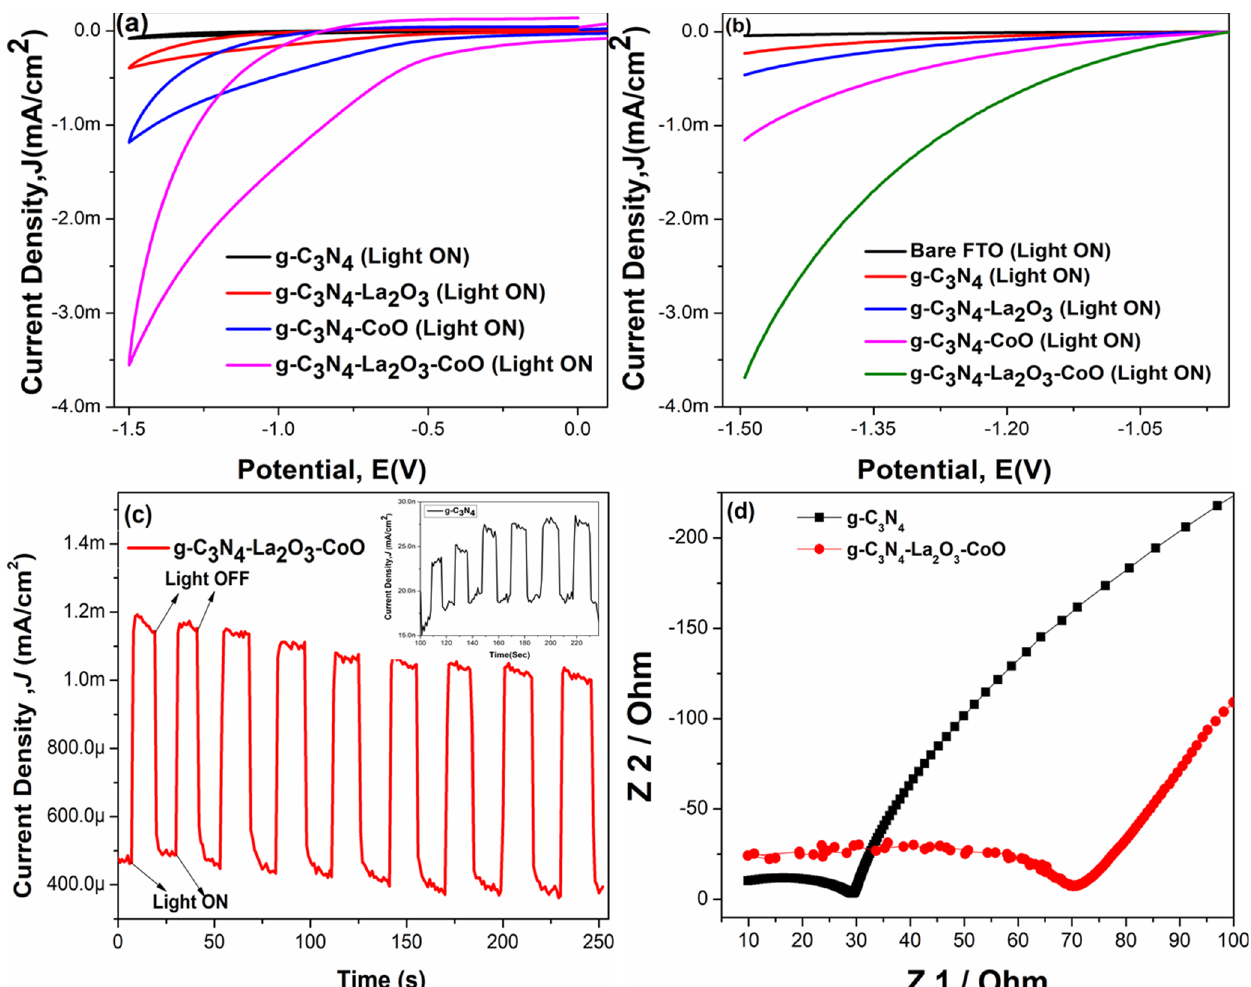
Figure 5. ( a ) Cyclic voltammetry of g-C 3 N 4 , La 2 O 3 –g-C 3 N 4 , CoO–g-C 3 N 4 , and La 2 O 3 –CoO–g-C 3 N 4 nanocomposites. ( b ) Lin- ear sweep voltammetry curves for g-C 3 N 4 , La 2 O 3 –g-C 3 N 4 , CoO–g-C 3 N 4 , and La 2 O 3 –CoO–g-C 3 N 4 nanocomposites. ( c ) Chronoamperometry measurements of g-C 3 N 4 and La 2 O 3 –CoO–g-C 3 N 4 nanocomposite. ( d ) Impedance analysis of g-C 3 N 4 and La 2 O 3 –CoO–g-C 3 N 4 nanocomposite. All the photoelectrochemical measurements were conducted in a standard three- electrode cell with 0.5 M Na 2 SO 4 solution, exposing the electrochemical cell to a 1 sun light irradiation source via a solar